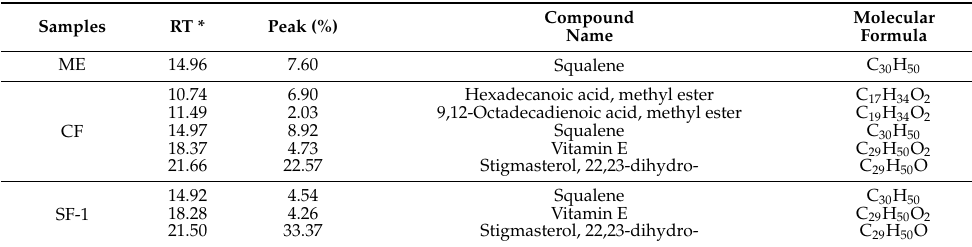
Table 1. Phytochemical components identified in the methanolic extract (ME), chloroform fraction (CF), and n -hexane subfraction-1 (SF-1) using GC–MS. Samples RT * Peak (%) Compound Name Molecular